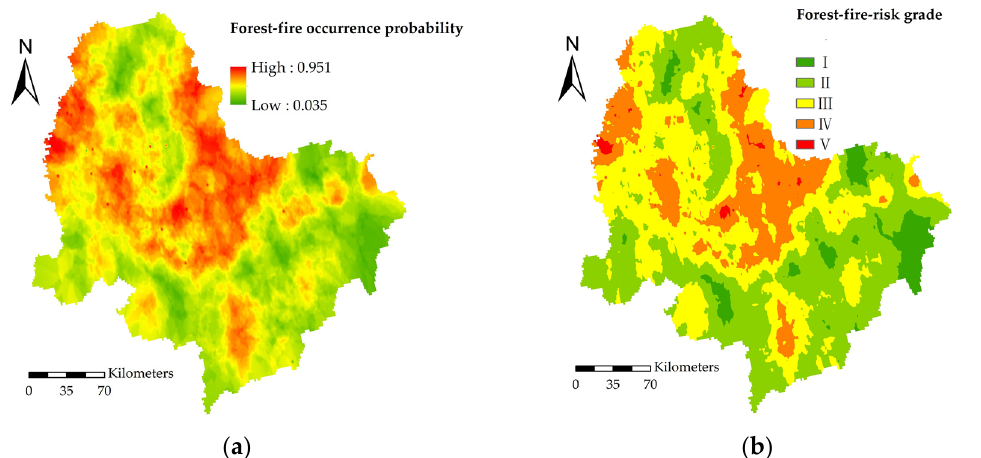
Figure 8. Forest-fire occurrence probability and risk distribution based on BPNN algorithm. ( a ) Forest-fire occurrence probability. ( b ) Forest-fire-risk distribution.